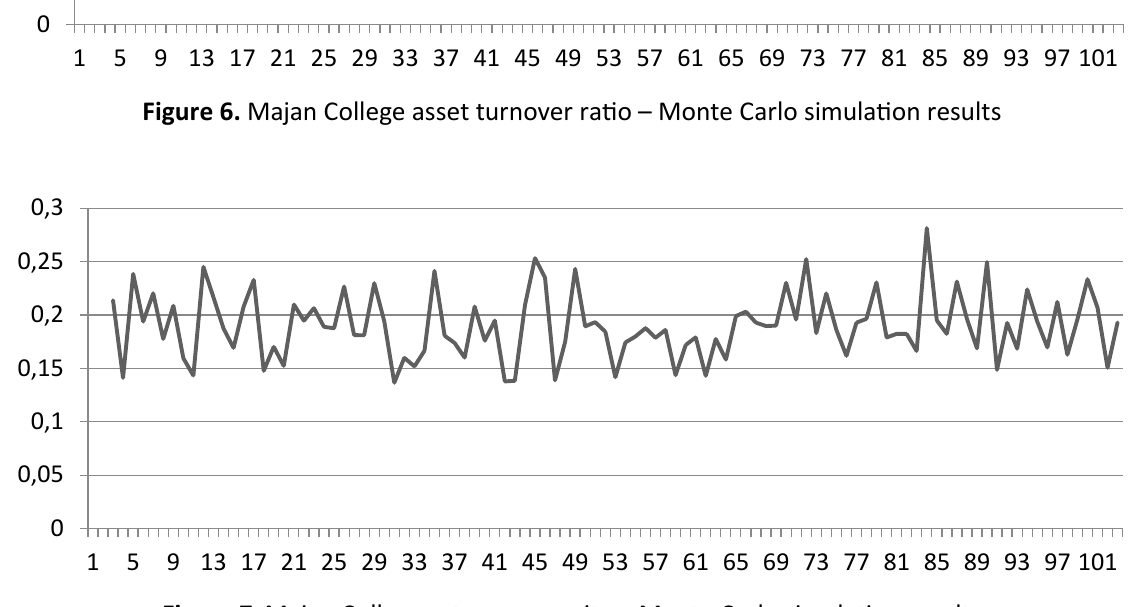
Figure 7. Majan College return on equity – Monte Carlo simulation results Comparatively, Majan College simulation results over ratio remain favorable in all the simulation indicate likelihood of good financial performance trials. The key lesson learned from the simulation even in bad times. As shown in Figure 7, ROE nev- analysis is that Dhofar University has financial er falls below 15 percent even under pessimistic sustainability issues because of the high levels of circumstances, and current ratio and asset turn- debt and high debt equity